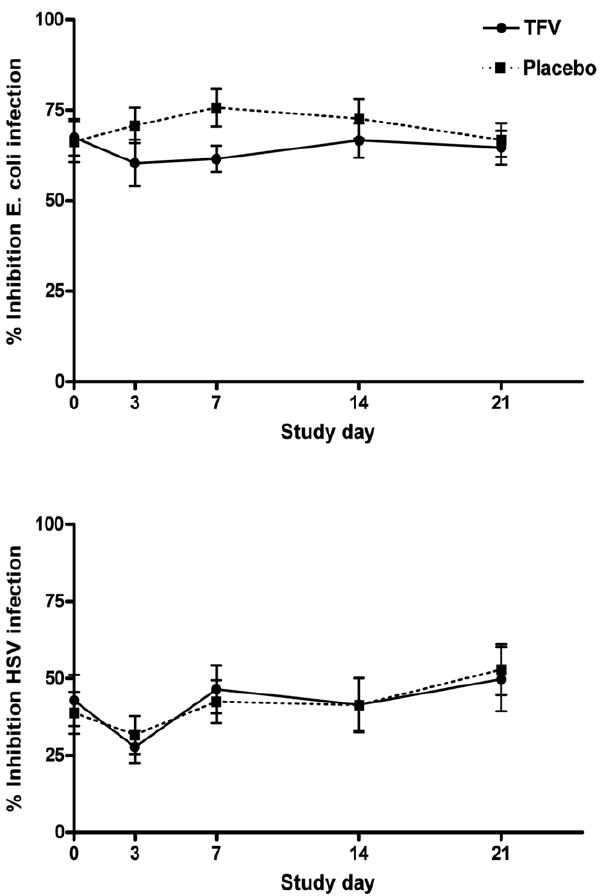
Figure 5. Endogenous anti- E. coli and anti-HSV activity following vaginal application of TFV and placebo gel. The percentage inhibition of E. coli was determined relative to colonies formed on control plates treated with GTB (upper panel). Vero cells were infected with HSV-2(G) mixed 1:1 with CVL or control buffer (lower panel). Results are presented as mean percentage inhibition of cfu or plaque forming units (pfu) 6 SE. All samples were tested in duplicate in two independent